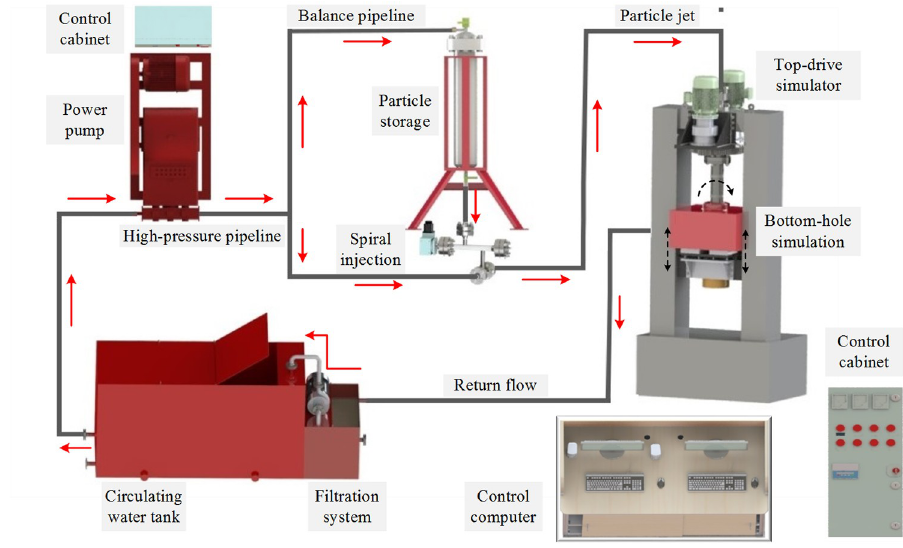
Fig 9. Overall design scheme of particle jet coupled impact